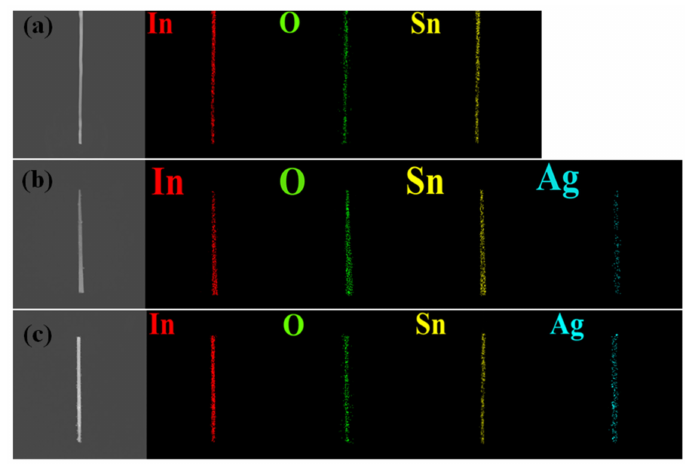
Figure 3. EDS mapping of the ( a ) ITO NW ( b ) 1 at% Ag-ITO NW ( c ) 3 at% Ag-ITO